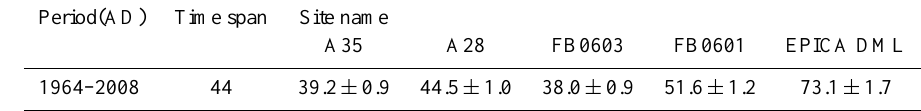
Table 3b. Annual accumulation rates derived from firn core studies at sites between A35 and EPICA